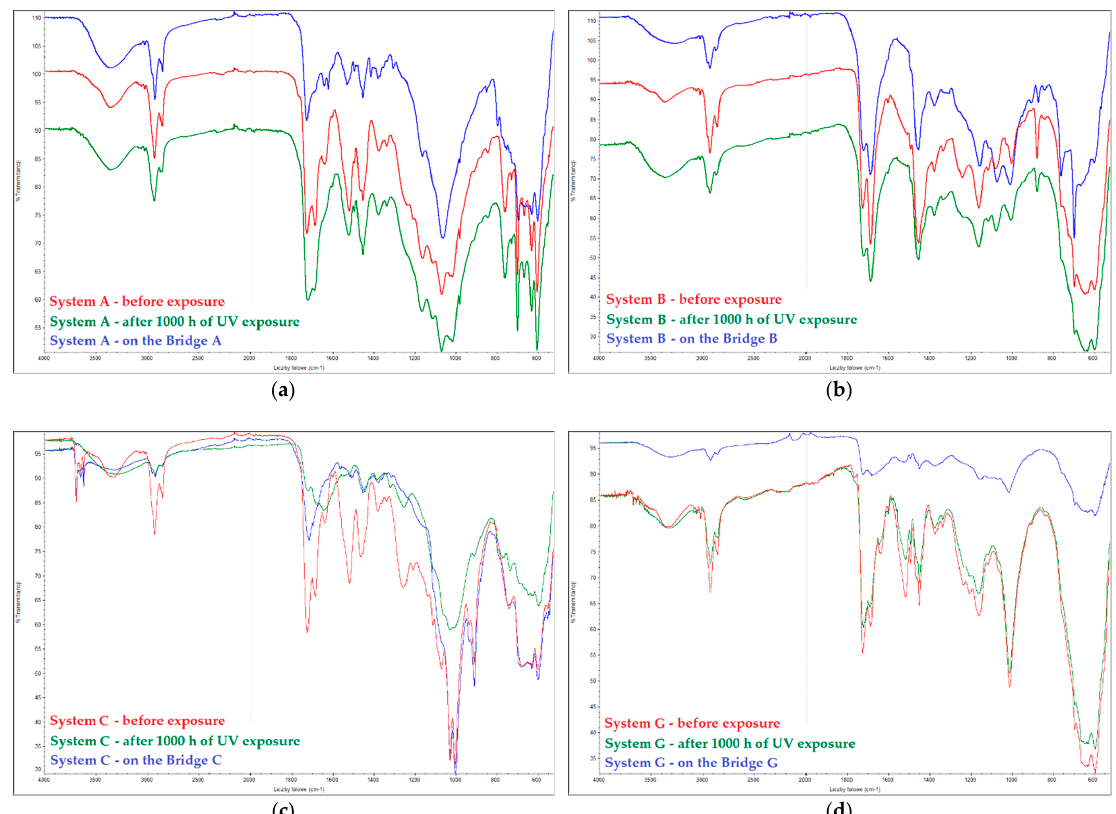
Figure 2. Spectra of topcoats in coating systems: ( a ) system A; ( b ) system B; ( c ) system C; ( d ) system G. Red line, before exposure; green line, after 1000 h of exposure in the UV chamber; blue line, on bridges.